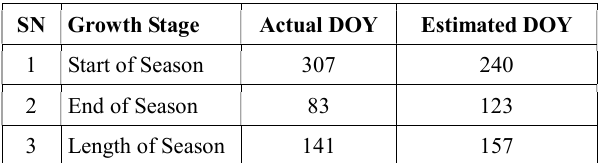
Figure 5. Crop growth stages for sample Wheat fields The field wise estimated and actual mean of SOS, EOS and LOS are shown in Table 1.